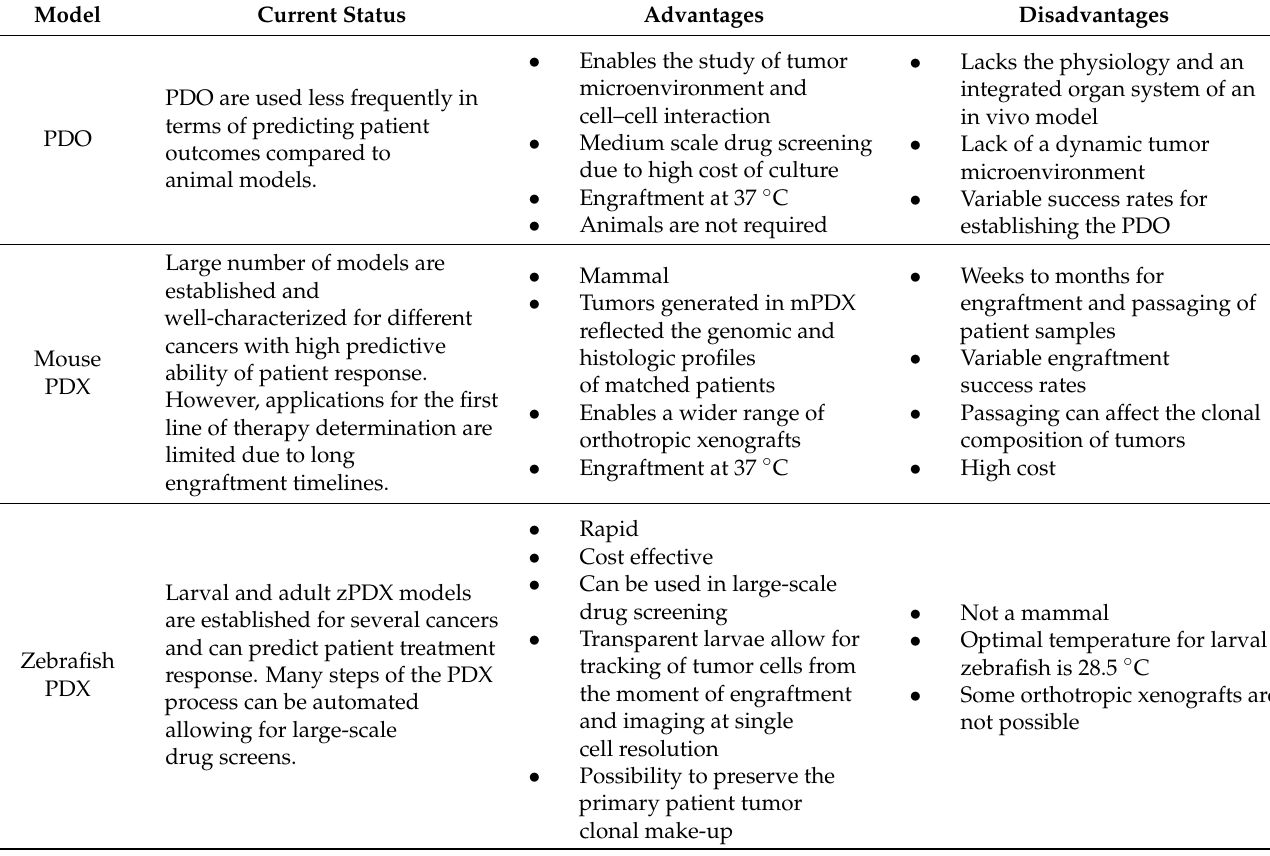
Table 2. Comparison between the different avatar